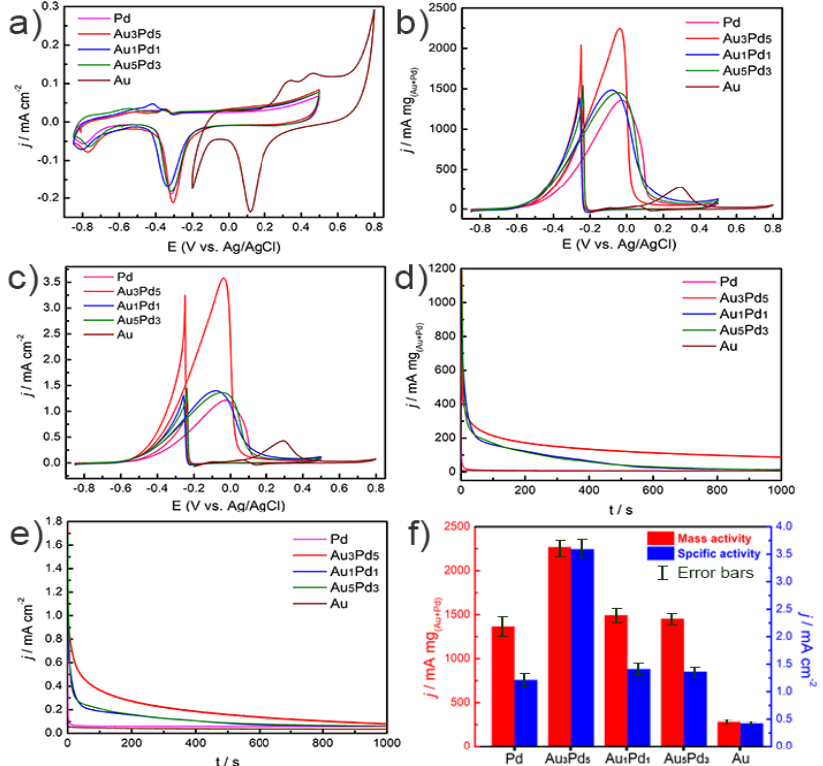
Figure 5. ( a ) CVs obtained with Pd, Au3@Pd5, Au1@Pd1, Au3@Pd3 DNPs and Au NPs. on GCE in 0.1 M KOH were normalized with respect to the ECSA of each catalyst, respectively. Catalytic ( b ) mass and ( c ) specific activities of the different materials in the EOR with 0.1 M KOH + 0.5 M ethanol. (Scan rate = 50 mV/s). CA curves of ( d ) mass activity and ( e ) specific activity obtained with the different catalysts in 0.1 M KOH + 0.5 M ethanol at −0.1 V vs . Ag/AgCl. ( f ) Comparison of EOR mass and specific activities with error bars between the different catalysts.